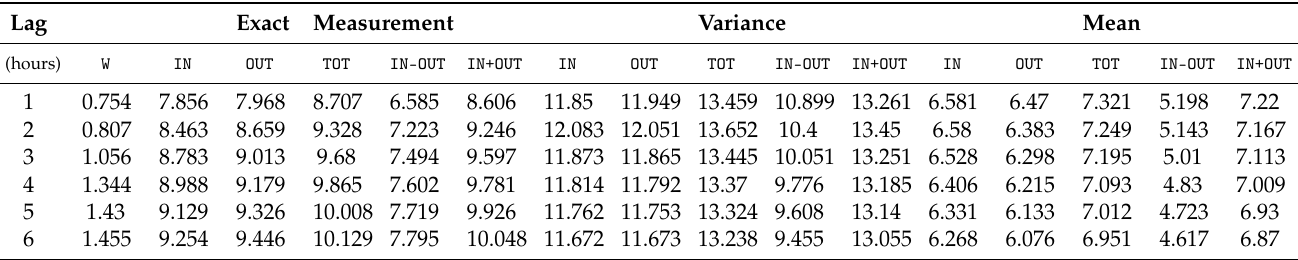
Table 3. Suprema (cid:101) ∗ and (cid:101) ∗ computed according to Equation (15), for hive H17 and for 5 types of T W traffic, 5 variances, and 5 means; IN—incoming traffic; OUT—outgoing traffic; TOT—total traffic; LAT—lateral traffic; IN—OUT (difference between IN and OUT), IN + OUT (sum of IN and OUT); TOT = IN + OUT + LAT; W column gives (cid:101) ∗ for weight measurements and corresponding lags; W IN, OUT, TOT, and LAT are non-negative integers; exact measurement columns give (cid:101) ∗ for exact W measurements of IN, OUT, TOT, IN-OUT, IN+OUT and lags; variance columns give (cid:101) ∗ for σ 2 (X), T where X ∈ {IN, OUT, TOT, IN-OUT, IN+OUT} and lags; mean columns give (cid:101) ∗ for µ (X), where where T X ∈ {IN, OUT, TOT, IN-OUT, IN+OUT}.